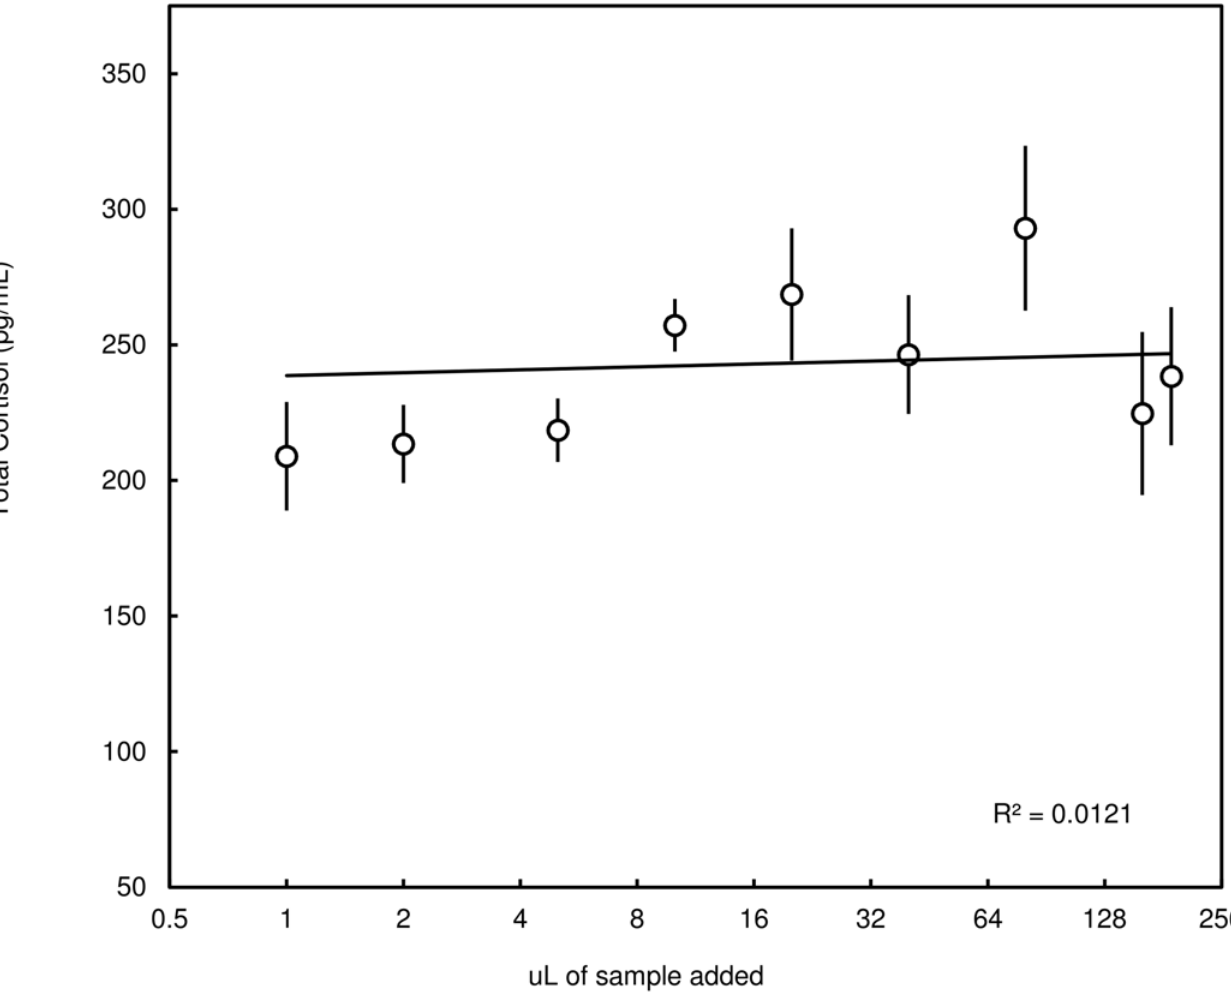
Fig 2. Results from matrix interference assessment. A standard solution (final concentration 240pg/ml) was spiked with either phosphate-buffered saline or a set of serial dilutions of a pooled sample ( “ uL of sample added ” ) composed of blubber cortisol extracts from four individuals to make a final equivalent volume of 240ul. The concentration of cortisol contributed from the pooled sample (neat = ± 398.5pg/ml) was subtracted from each sample-spiked measurement so its contribution would be factored out of the assessment. Little to no evidence of matrix interference was observed (r 2 = 0.012, p = 0.78).